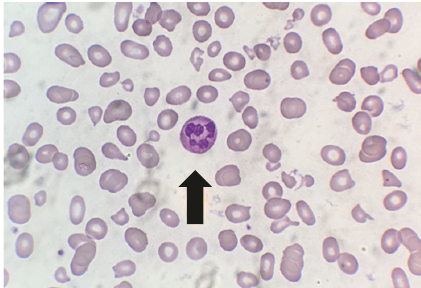
Figure 1: CT scan of the abdomen and pelvis showing inflammatory fat stranding in the small bowel mesentery (axial view).